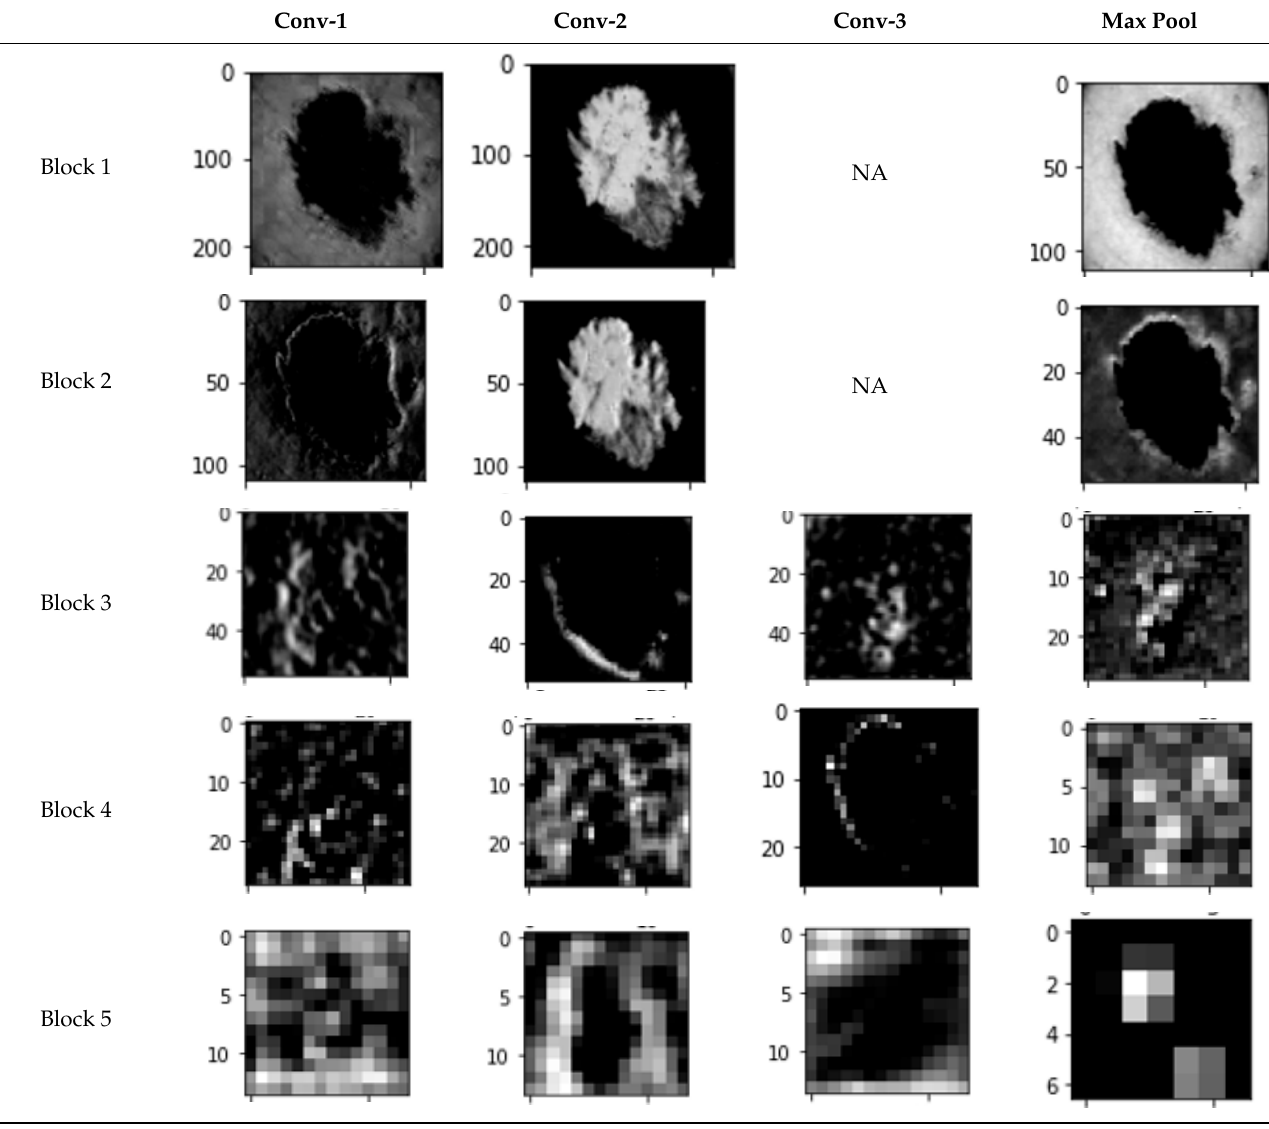
Table 3. Filtered Images after Convolution and Maxpool Layer.